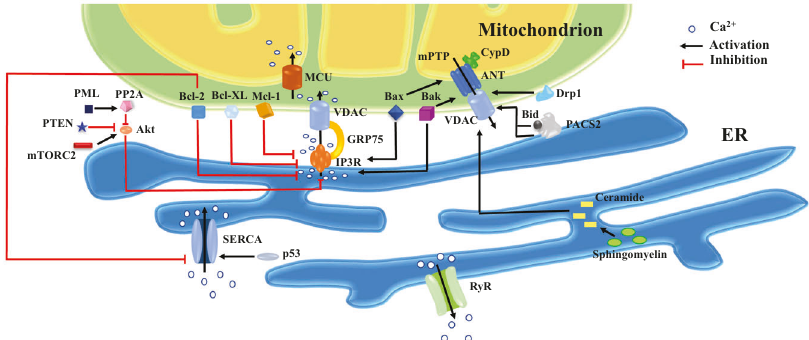
Fig. 2 Representation of principle pro- and anti-apoptotic molecules at MAMs. Death signals governed by MAMs may be present in various forms: 1. ER perfuses Ca 2 + into mitochondria and massive Ca 2 + in mitochondria serves as an initial instigating signal for cell death. Multiple factors alter Ca 2 + levels in mitochondria via directly or indirectly action on the IP3R-GRP75-VDACs complex, for example, anti-apoptotic members of Bcl-2 family (e.g., Bcl-2, Bcl-XL and Mcl-1) restrain Ca 2 + release by directly modulating IP 3 R activity, while molecules such as mTORC2, PTEN and PML regulate IP 3 R-mediated Ca 2 + ef fl ux indirectly by acting on Akt. Bcl-2 and p53 modulate Ca 2 + enrichment in the ER via altering SERCA activity; 2. PACS2 translocates from ER to mitochondria along with the translocation and activation of Bid, leading to increased permeability of OMM and release of pro-apoptotic factors. Other mitochondrially-targeted players including Bax/Bak and Drp1 can also trigger mPTP opening and subsequently initiation of apoptosis; 3. Ceramide synthesis and collection contribute to pores formation across the OMM, inducing cytosolic release of pro-apoptotic factors and stress signal delivery from ER to mitochondria. The ER-mitochondria-ER ampli fi cation loop of pro-apoptotic signals helps to coordinate death events between these two organelles. Abbreviations: Akt, serine-threonine protein kinase; ANT, adenine nucleotide translocase; Bax, Bcl-2-associated X protein; Bak, Bcl-2 antagonist killer; Bcl-2, B-cell lymphoma 2; Bcl-XL, B-cell lymphoma-extra large; Bid, BH3-interacting domain death agonist; CypD, Cyclophilin D; Drp1, dynamin-related protein 1; ER, endoplasmic reticulum; GRP75, glucose-regulated protein 75; IP3R, inositol 1,4,5-triphosphate receptors; Mcl-1, myeloid cell leukemia factor-1; MCU, mitochondrial Ca 2 + uniporter; mPTP, mitochondrial permeability transition pores; mTORC2, mammalian target of rapamycin complex 2; PACS2, phosphofurin acidic cluster sorting protein 2; PML, promyelocytic leukemia protein; PP2A, protein phosphatase 2A; PTEN, phosphatase and tensin homolog; RyR, ryanodine receptor; SERCA, sarco(endo)plasmic reticulum calcium-ATPases; VDAC, voltage-dependent anion